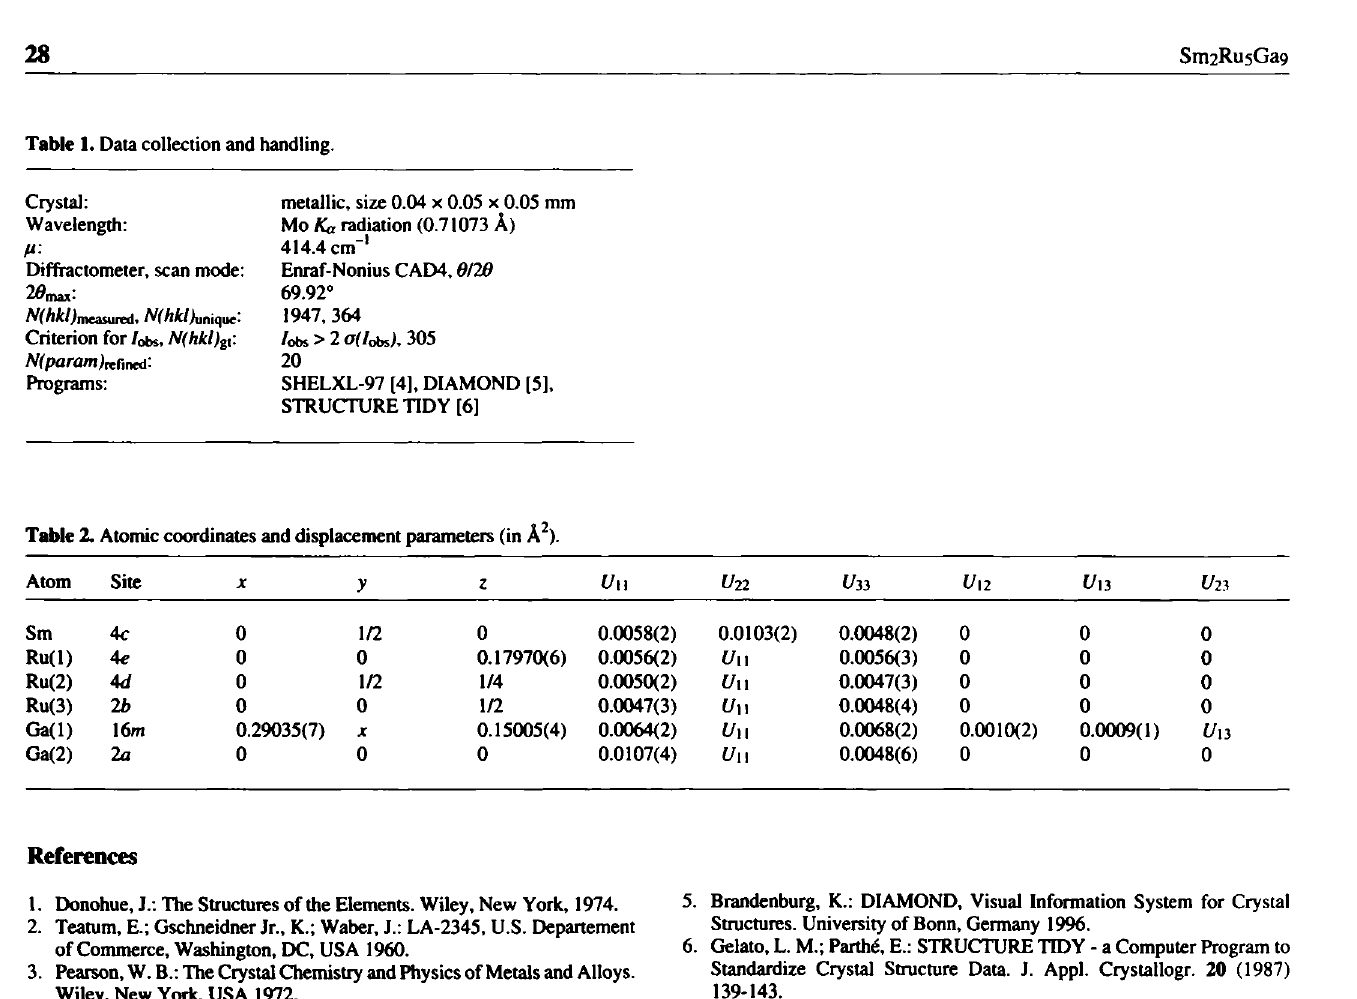
Table 2. Atomic coordinates and displacement parameters (in Â 2